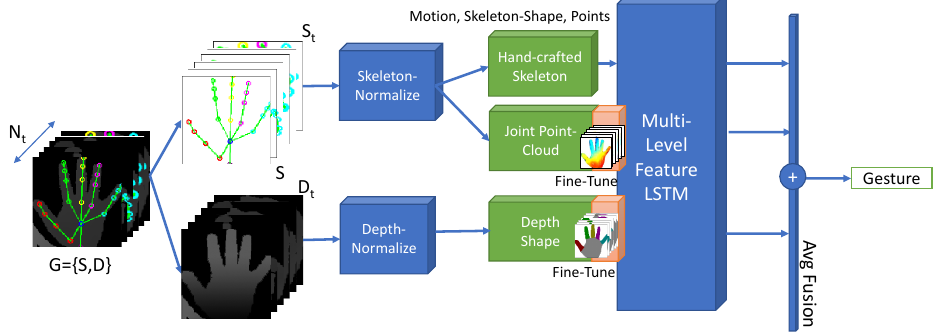
Figure 2. Overview of the proposed system for dynamic hand gesture